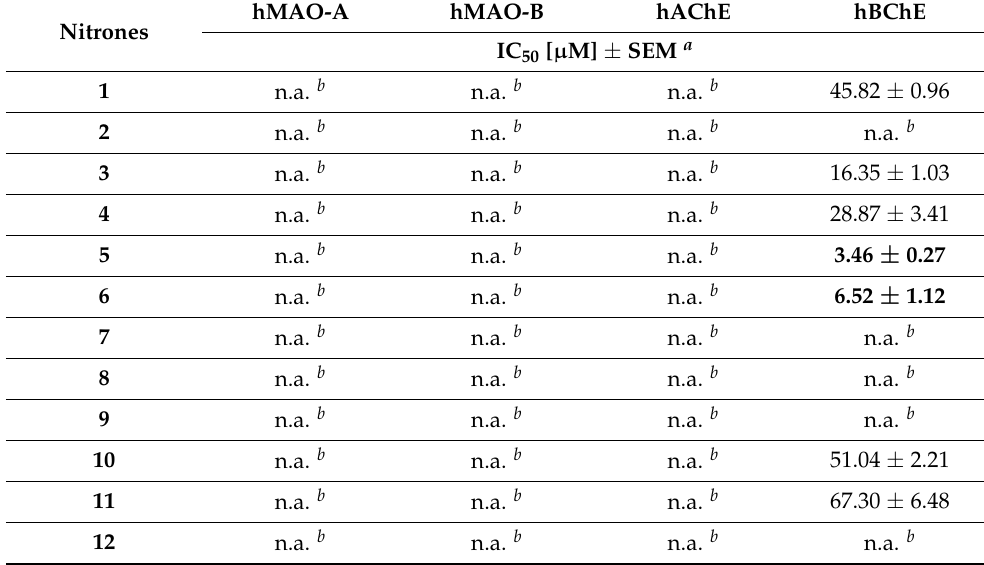
Table 2. In vitro ChE and MAO inhibitory potencies of nitrones 1 – 12 .